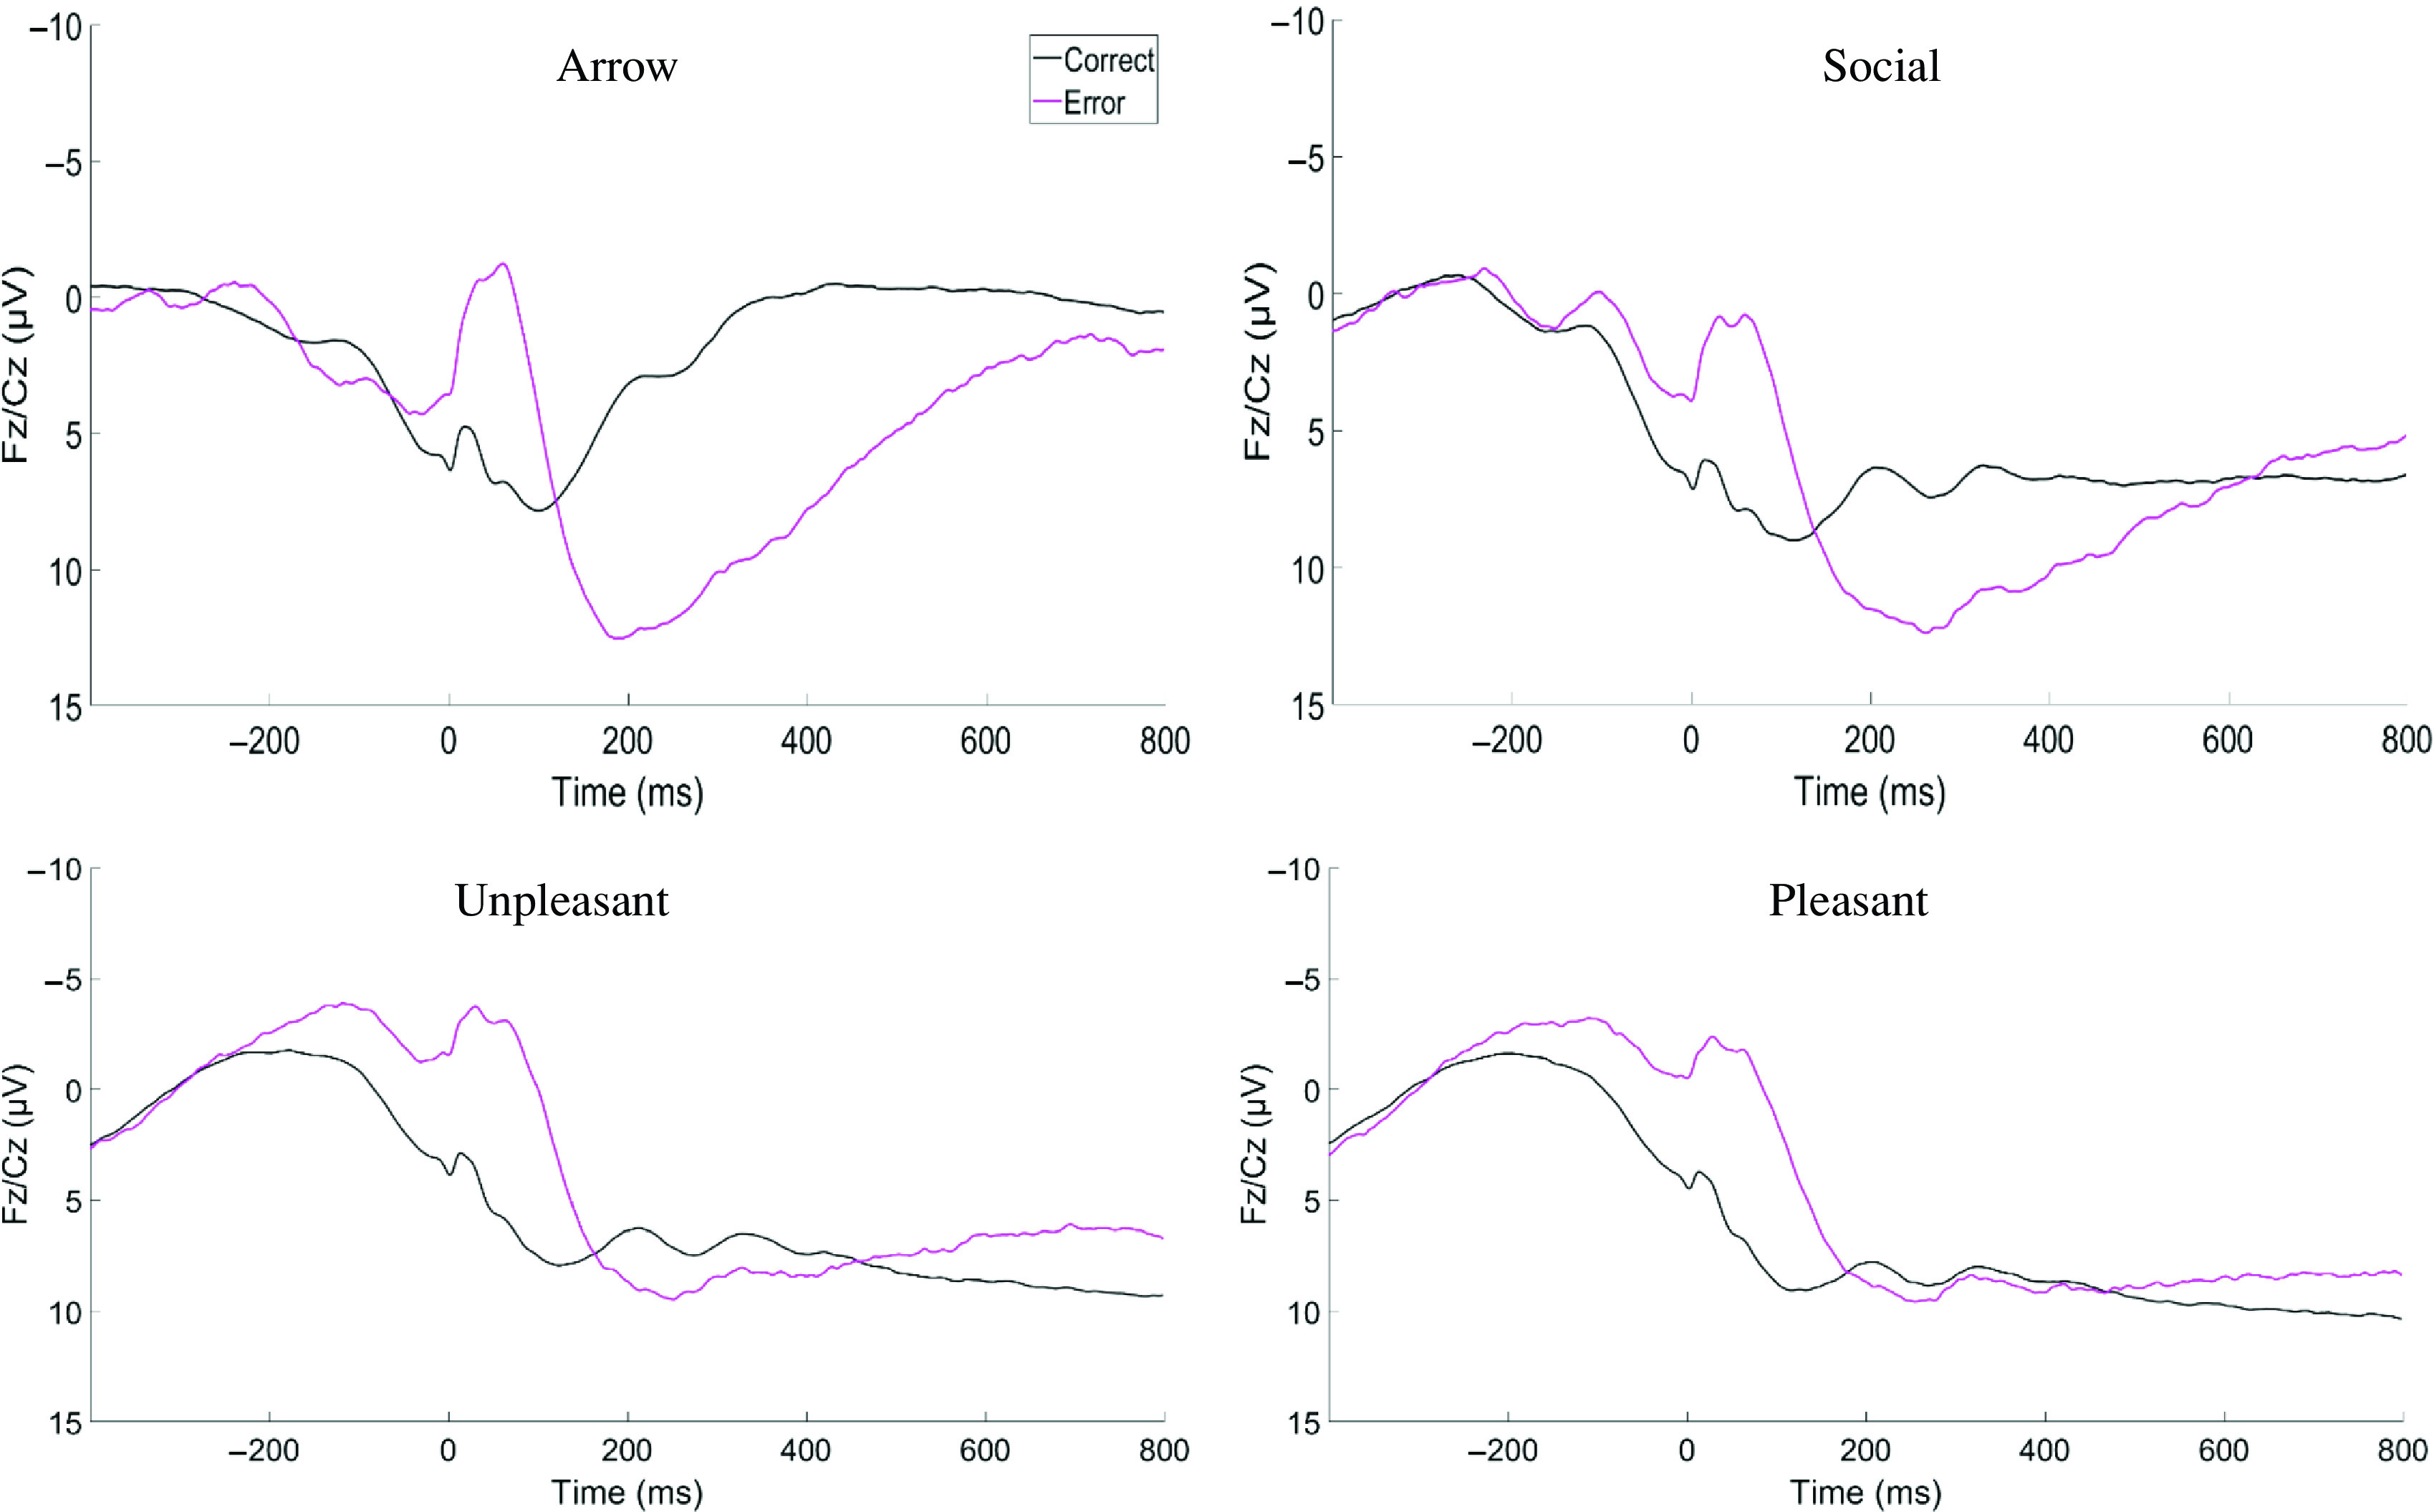
The event-related potential amplitudes of each task (red line indicates the ERP when an error is made and the black line indicates the ERP when a correct response is made).